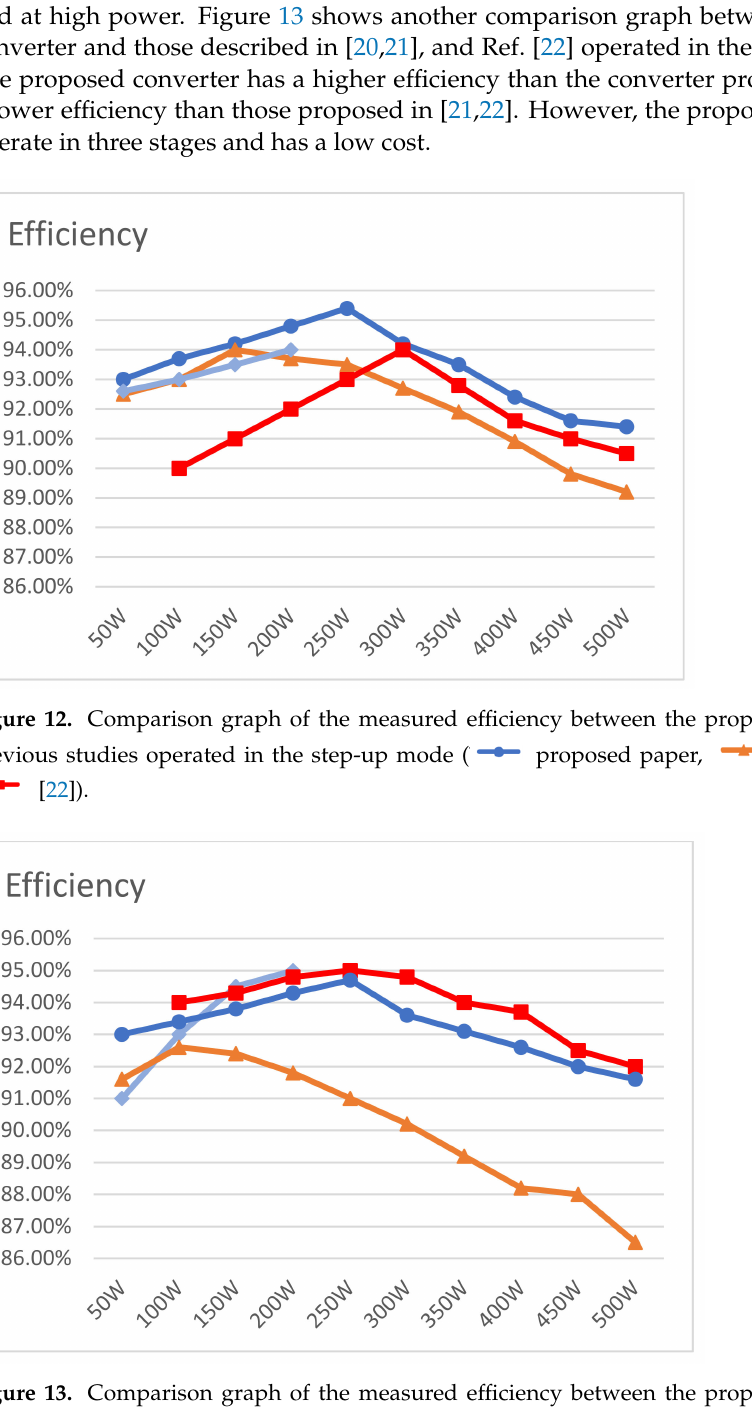
Figure 11. Efficiency curve of the proposed three-port bidirectional converter.